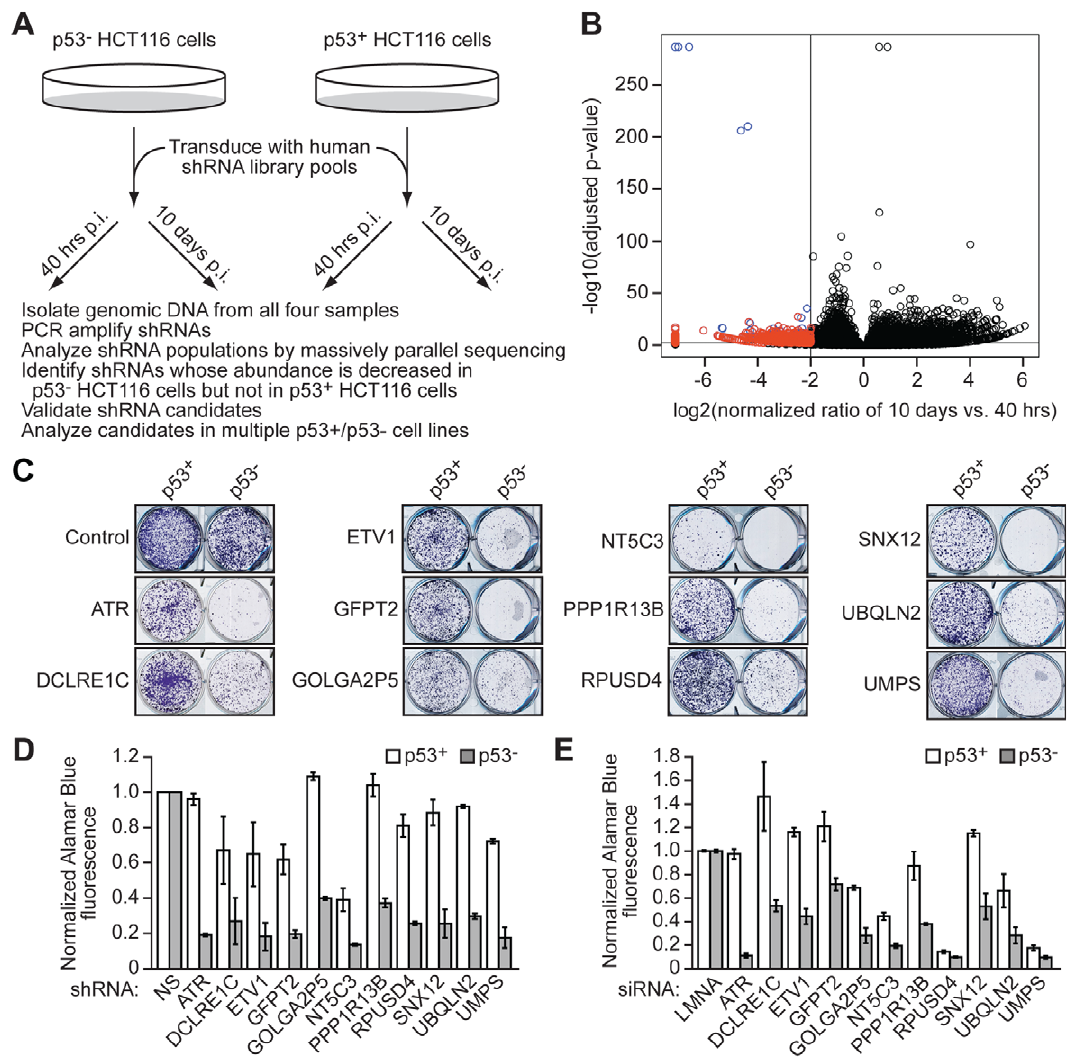
Figure 1. A genome-wide shRNA–based synthetic interaction screen identifies candidate genes preferentially required for proliferation of p53 2 cells. (A) Schematic summary of the screen. p53 + and p53 2 HCT116 cells were infected in parallel with a pooled lentiviral human shRNA library. The shRNA population was analyzed by massively parallel sequencing at 40 hours and 10 days post-infection (p.i.). (B) Volcano plot. The horizontal and vertical lines indicate the selection criteria. The red points represent shRNAs diminished $ 4-fold in p53 2 HCT116 cells and # 2-fold in p53 + HCT116 cells at 10 days p.i. relative to 40 hours p.i. Blue points represent shRNAs diminished in both p53 + and p53 2 cells, and black points represent shRNAs not diminished in either p53 + or p53 2 cells. (C) Colony formation assay. p53 + and p53 2 HCT116 cells infected with a lentivirus expressing individual candidate shRNAs were selected with puromycin and plated in a serial dilution series in 6-well plates. Only one dilution set is shown. Colonies were fixed and stained with crystal violet. Control refers to the empty lentiviral vector, pGIPZ. (D) Proliferation assay. p53 + and p53 2 HCT116 cells infected with a lentivirus expressing each individual candidate shRNA, or as a control a non-silencing (NS) shRNA, were selected with puromycin and cell proliferation determined by an Alamar Blue fluorescence assay. The results were normalized to that obtained with a NS shRNA, which was set to 1. Error bars represent SD. (E) Proliferation of p53 + and p53 2 HCT116 cells transfected with an siRNA directed against an individual candidate gene, or a control lamin A/C (LMNA) siRNA, was determined by an Alamar Blue fluorescence assay. The results were normalized to that obtained with the control shRNA, which was set to 1. Error bars represent SD. mouse xenograft model. p53 + or p53 2 HCT116 cells expressing an shRNA against ATR or ETV1, or a control non-silencing shRNA, were injected subcutaneously into opposite flanks of the